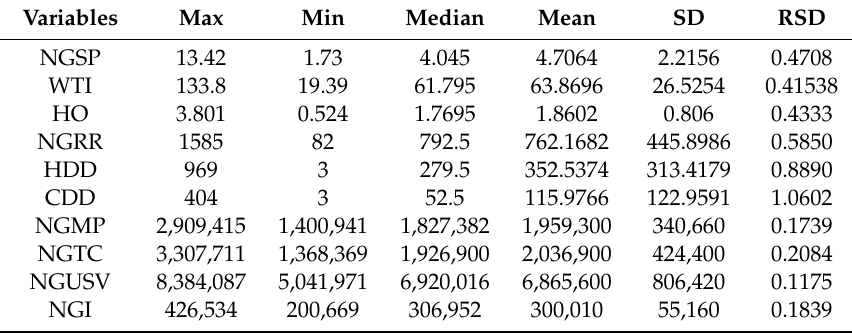
Table 2. Summary statistics of natural gas prices and relevant variables.